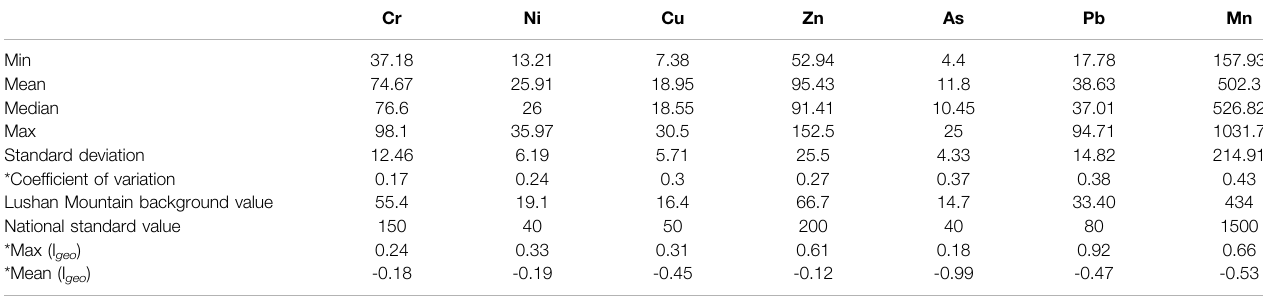
TABLE 3 | Variations in the concentration of heavy metal elements in the surface soil samples of Lushan Mountain (mg · kg − 1